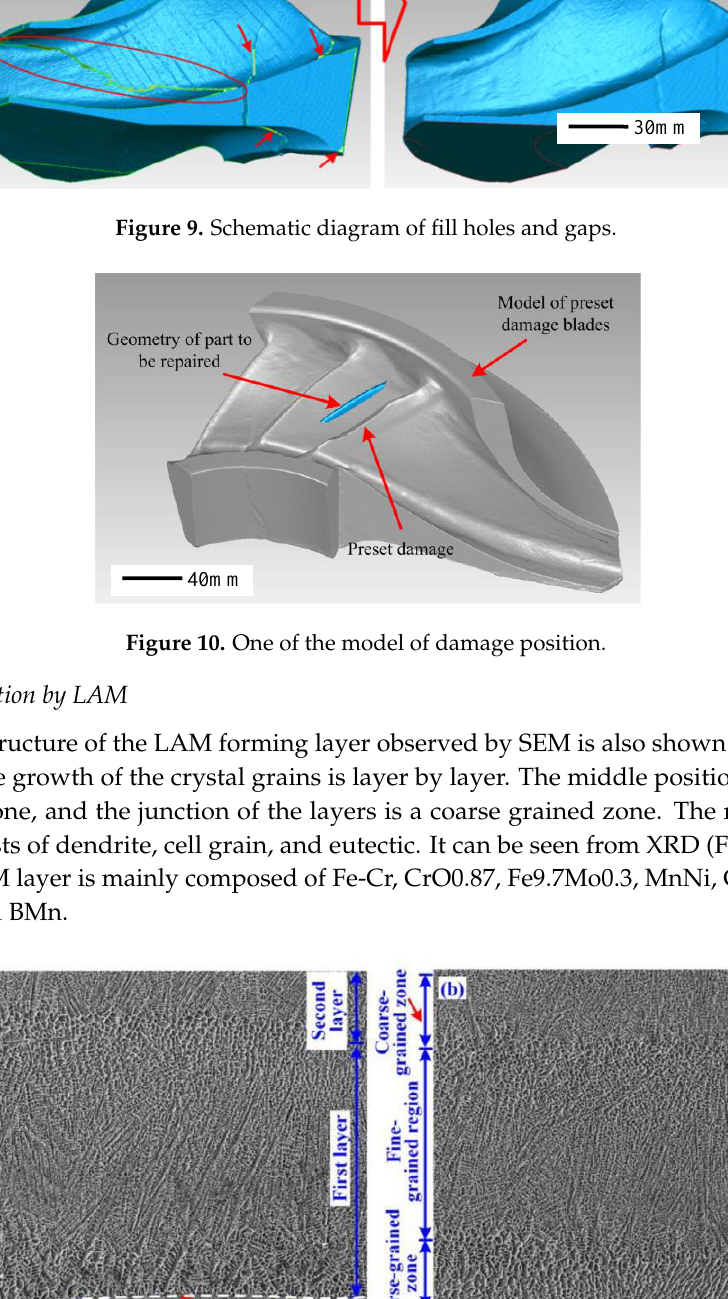
Figure 11. The grains structure of the specimen cross-section: ( a ) substrate and first layer, ( b ) second, third and fourth layer.